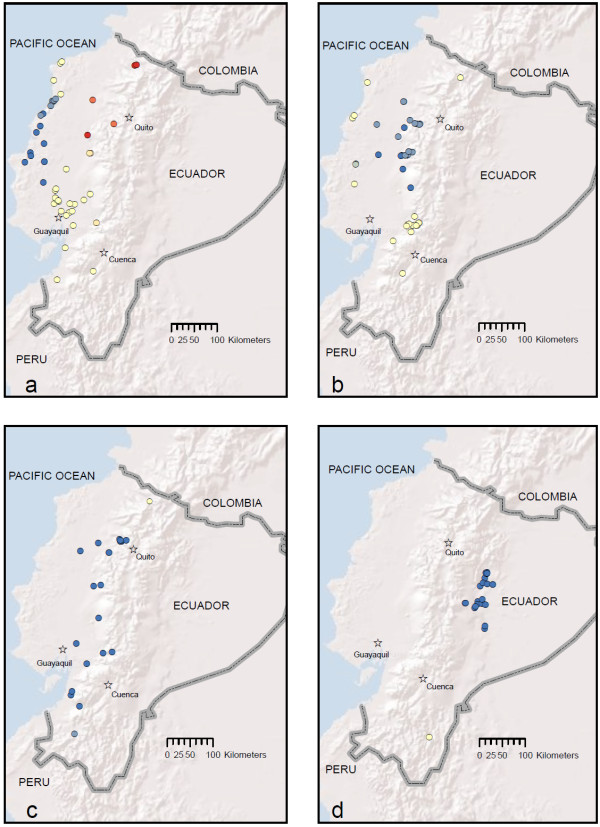
Hot Spot Analysis (Getis-Ord) results for a) An. albimanus, b) An. pseudopunctipennis, c) An. punctimacula and d) An. oswaldoi s.l.. Red and dark orange circles indicate significant clusters of high larval density sites, whereas blue circles indicate significant clusters of low larval density sites (p < 0.05). Map prepared in ArcGIS v.9.3 with ESRI World Terrain base [59].